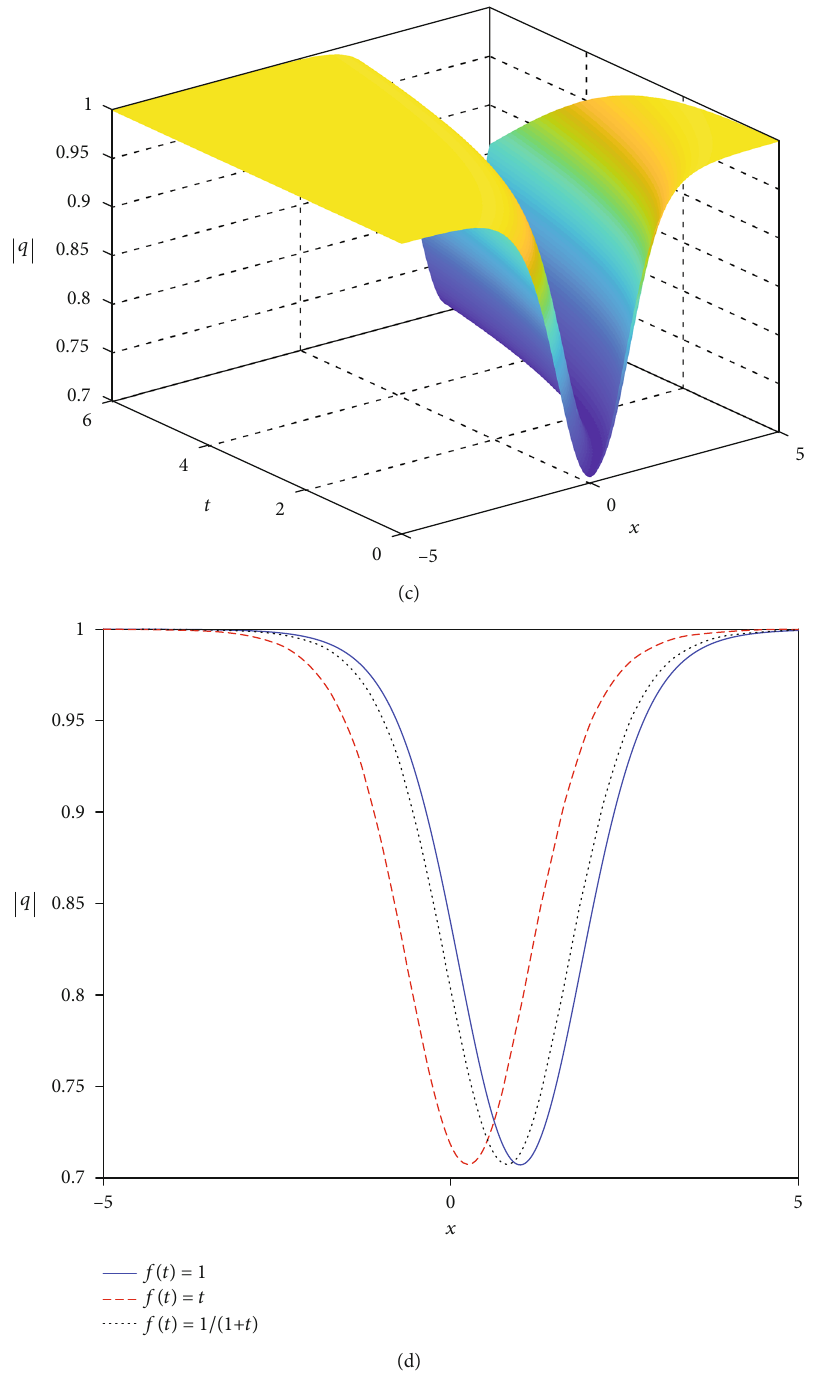
Figure 5: (a – c) The 3D wave shapes of j q j : (a) f ð t Þ = 1 , (b) f ð t Þ = t , and (c) f ð t Þ = 1/ ð 1 + t Þ . (d) The wave propagates along the x